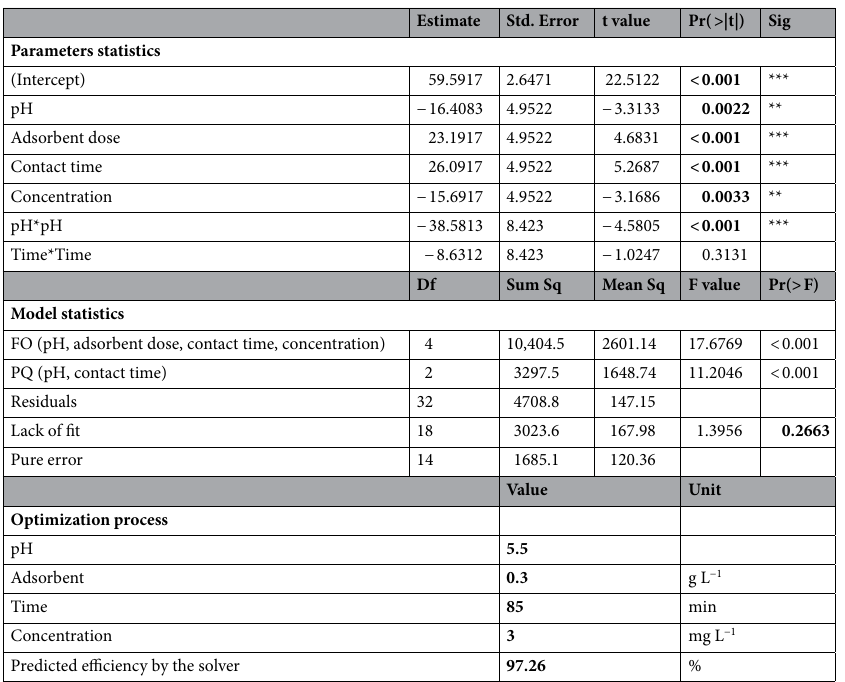
Estimate Std. Error t